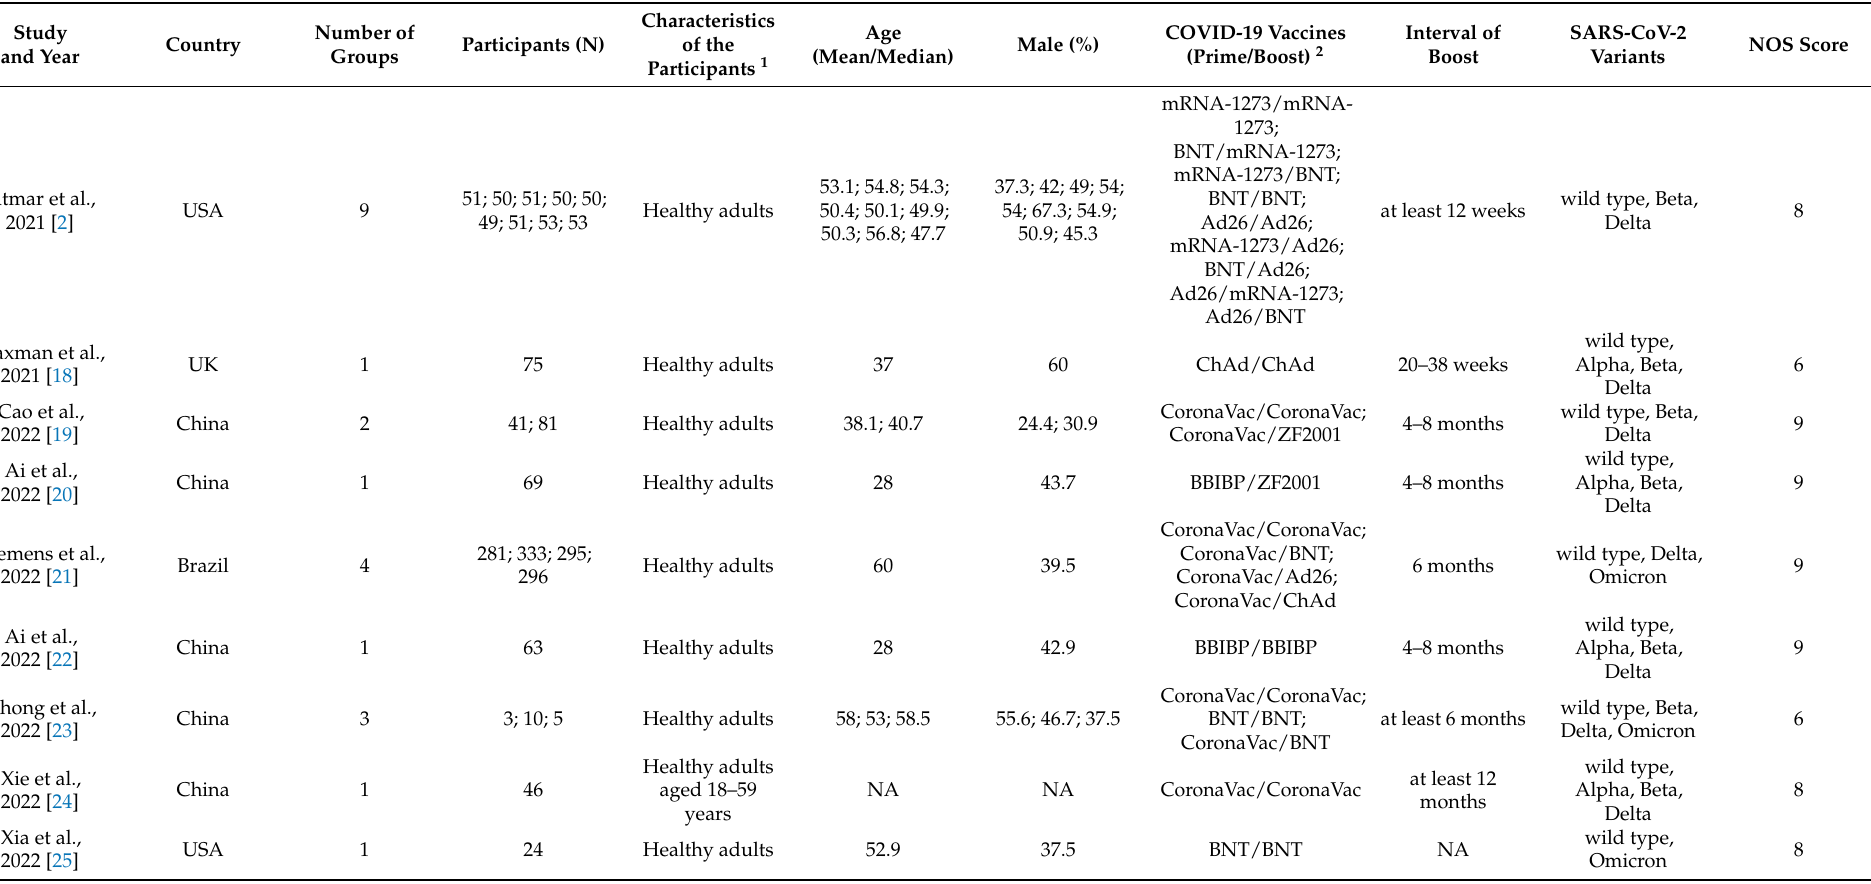
Table 1. Characteristics of the original studies included in the